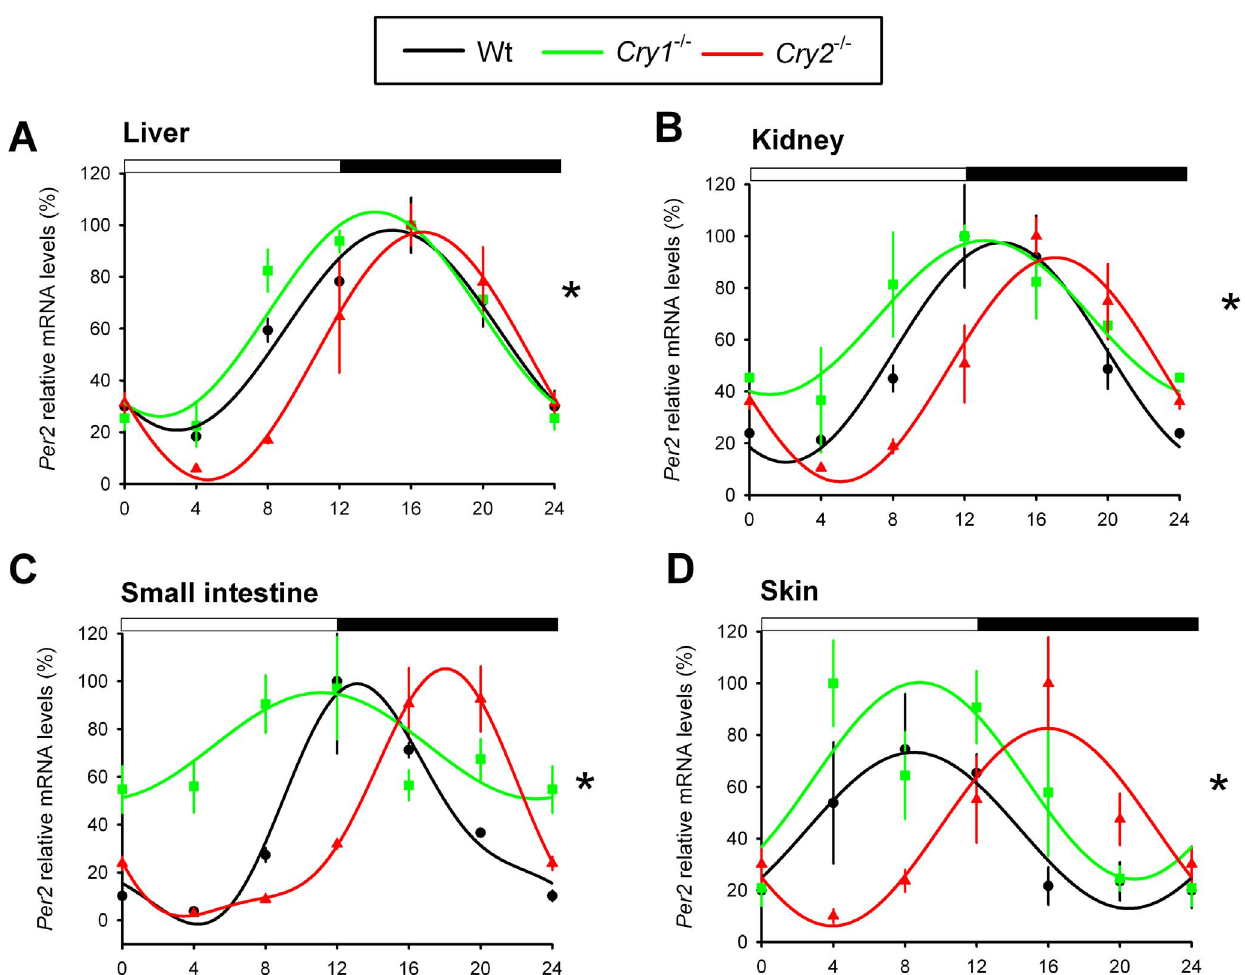
Figure 4. Per2 expression profiles in peripheral tissues of light-entrained Cry1 -/- and Cry2 -/- mice. Relative mRNA expression profiles of Per2 in the liver (A), kidney (B), small intestine (C), and skin (D) of light-entrained (LD 12:12) wild type (black), Cry1 -/- (green) and Cry2 -/- (red) mice, as measured by RT-qPCR. For each genotype, mRNA levels (mean 6 s.e.m) are expressed relative to the peak of expression (set at 100%) and fitted with a wave curve. The two-way ANOVA test revealed a significant effect of genotype and time interaction (*p , 0.05). Data at ZT0 and ZT24 are double- plotted for easier visualization of daily expression. The bar above panels indicates time of light on and off. doi:10.1371/journal.pone.0083602.g004 synchronous central SCN clock and behavioral rhythms in these clock mutant mice.